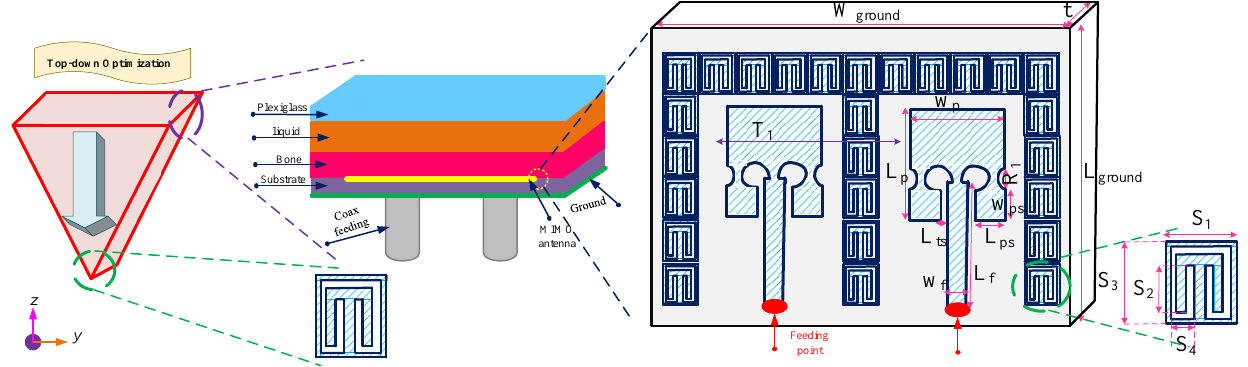
Figure 2. Hierarchy top-down optimization for configuring the implanted MIMO antenna geometry (width and length are in mm; drawing not in